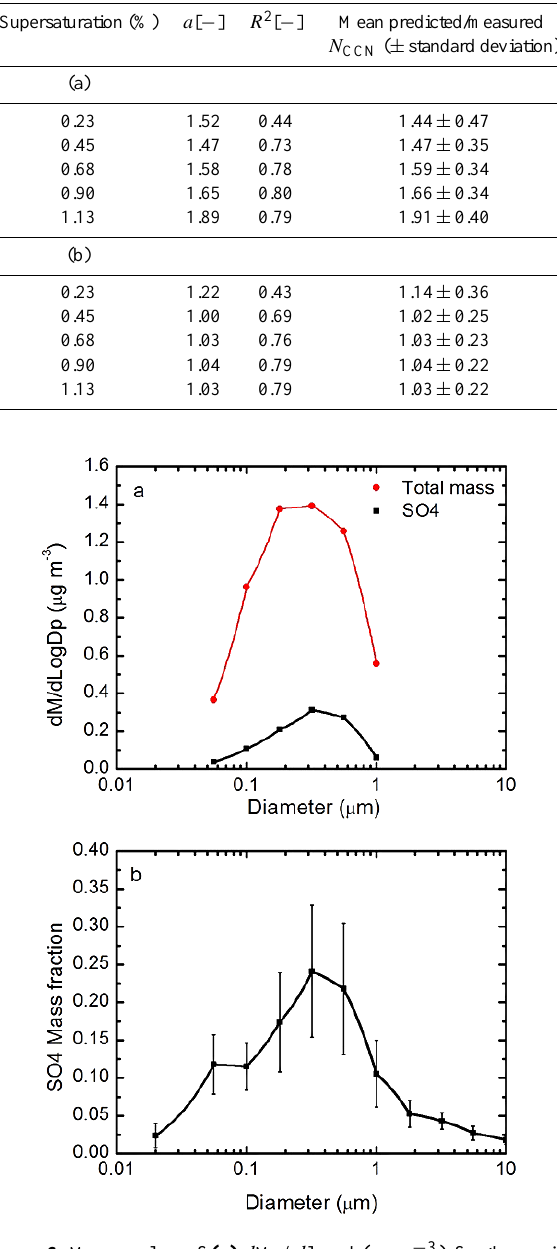
Table 3. (a) Details of the predicted vs. measured N CCN consider- ing chemical composition measured by ACSM. a is the slope of the fitted line using a linear regression, R 2 is the square of the correlation coefficient. (b) Details of the predicted vs. measured N CCN considering mean chemical-size dependency furnished by MOUDI + PIXE and ACSM hourly chemical composition.